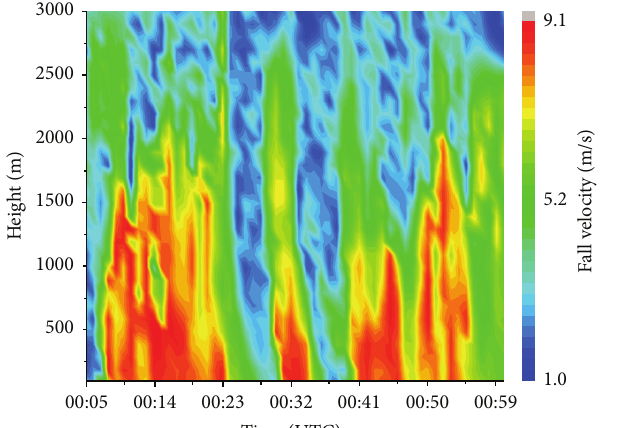
Figure 7: Fall speeds for raindrops at different heights during the first hour of the event.